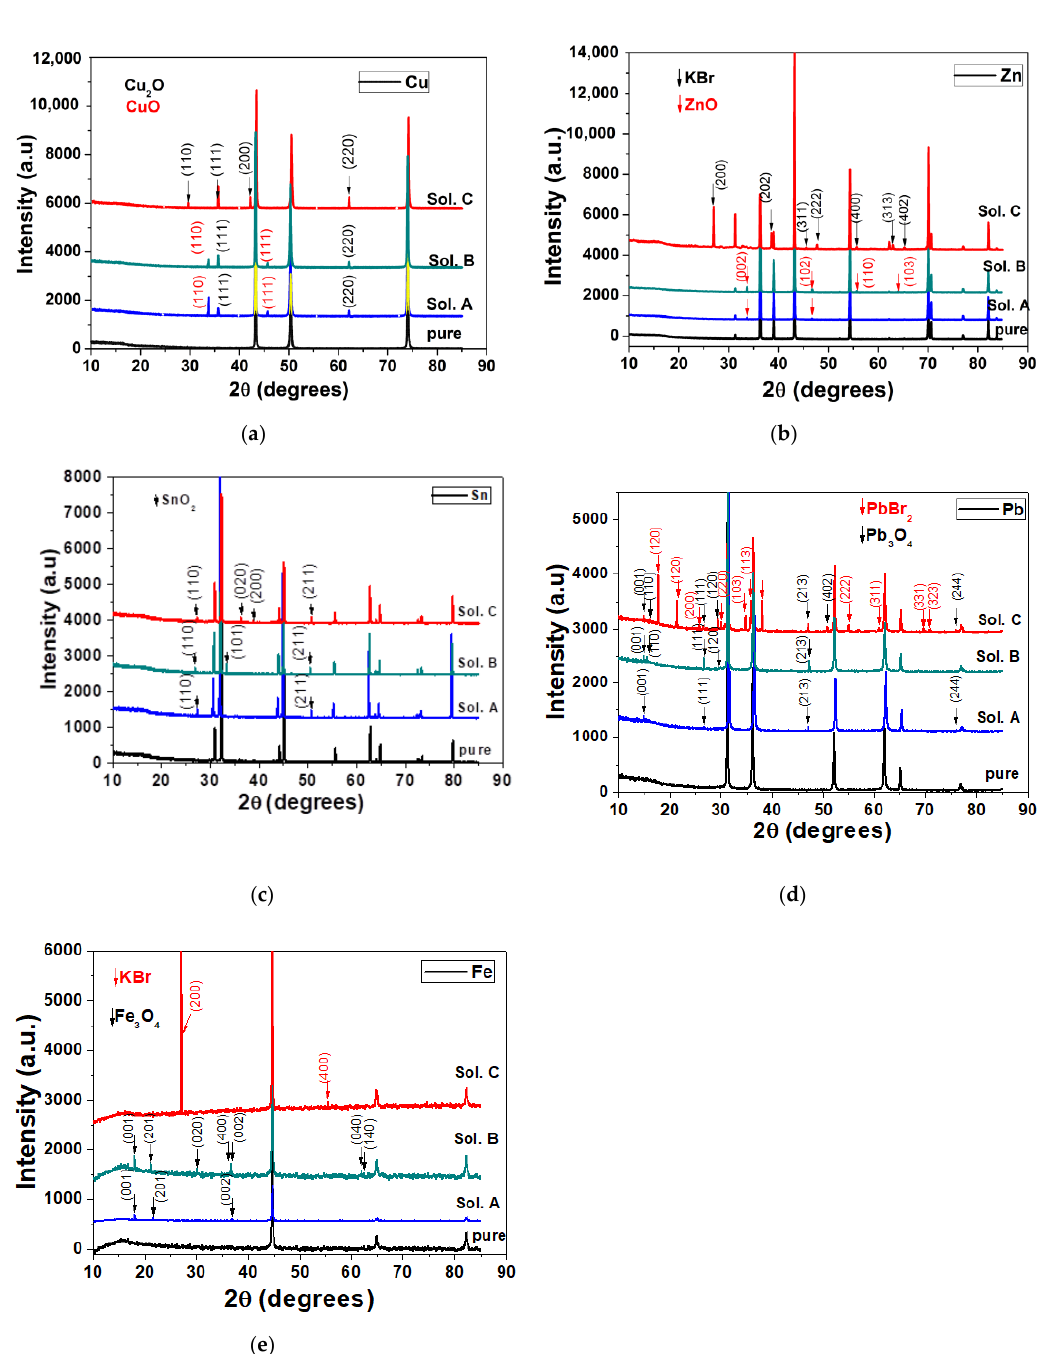
Figure 8. XRD diffractograms collected before and after 120 h immersion of electrodes in different bromide-based electrolytes: Cu ( a ); Zn ( b ); Sn ( c ); Pb ( d ); and Fe ( e ). The long immersion of the metals in different bromide-based electrolytes induces structural modifications for all electrodes, as shown in their XRD diffractograms. In the case of Cu electrode immersed in Sol. A and Sol. B, the XRD diffractograms shows a combination of CuO and Cu 2 O phases. By exposing the Cu electrode to Sol. C, the corrosion products change their composition and XRD diffractograms show only peaks related to the Cu 2 O phase. In the case of Sn, the additional diffraction peaks appearing in the diffraction pattern after 120 h were assigned to SnO 2 and their intensity increases in Sol. C. In the case of Pb the influence of the Sol. C is more obvious. The peaks in the XRD diffractograms were indexed with red arrows (for PbBr 2 phase) and black arrows (for Pb 3 O 4 phase). The predominance of PbBr 2 becomes